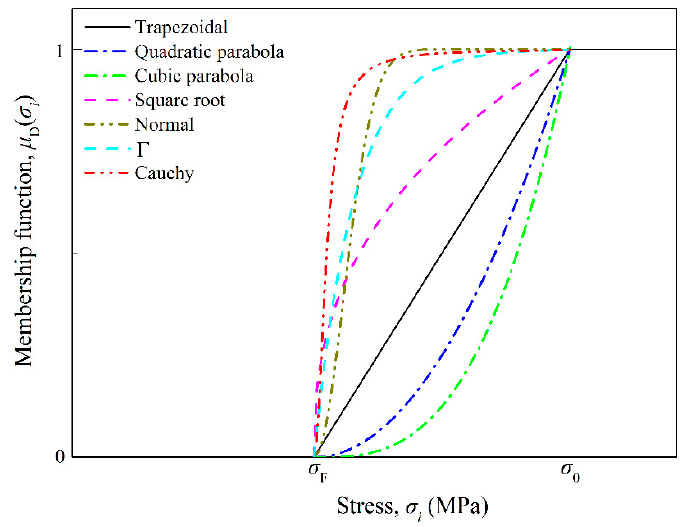
Figure 4. Curves of membership functions.